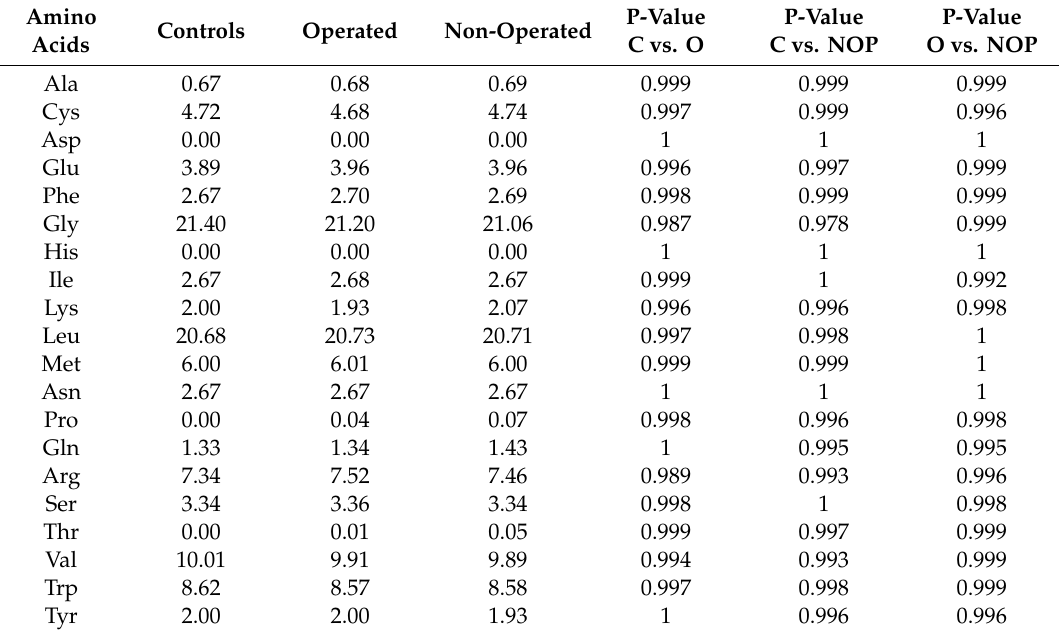
Table 2. Frequencies of amino acids according to populations.